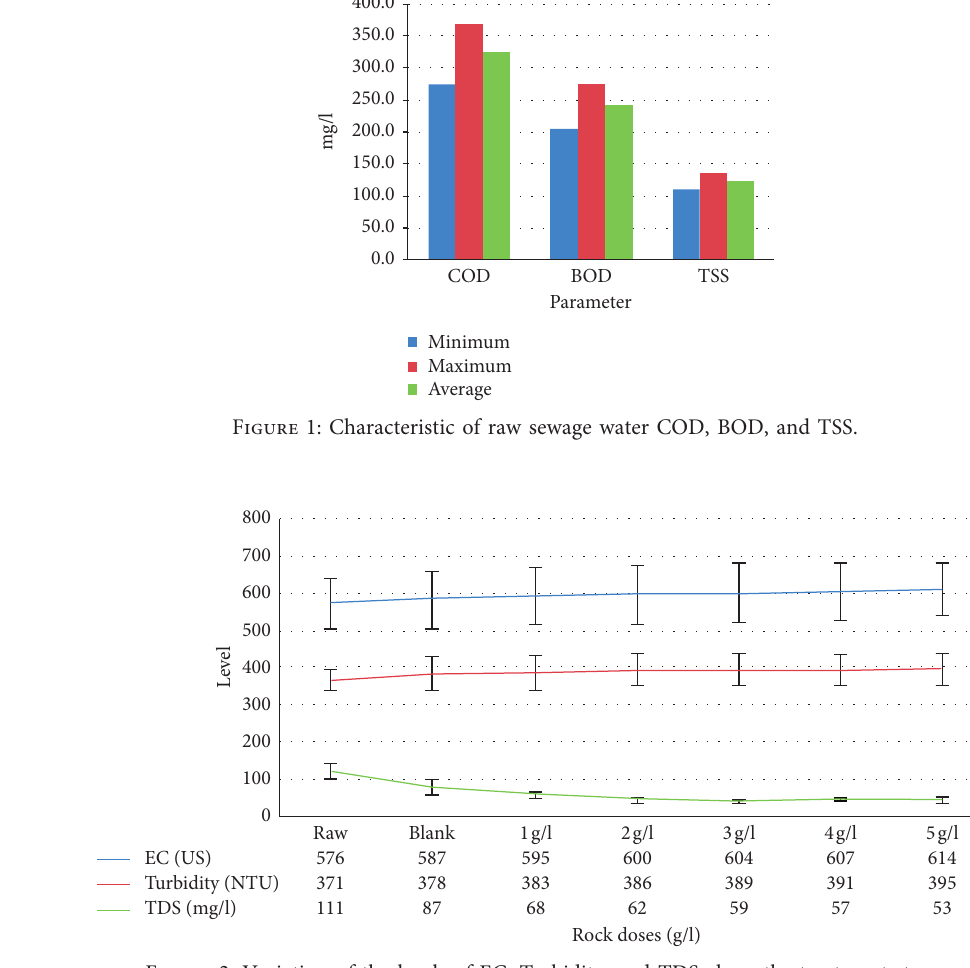
Figure 2: Variation of the levels of EC, Turbidity, and TDS along the treatment